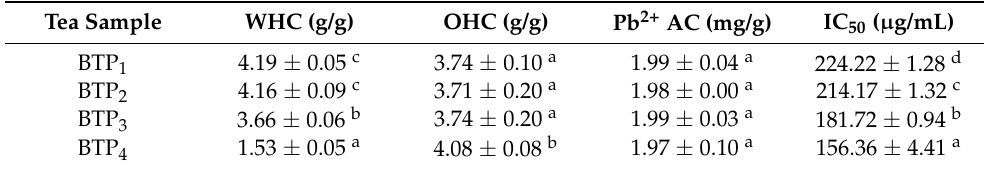
Table 3. Functional properties of BTPs at different pulverizing